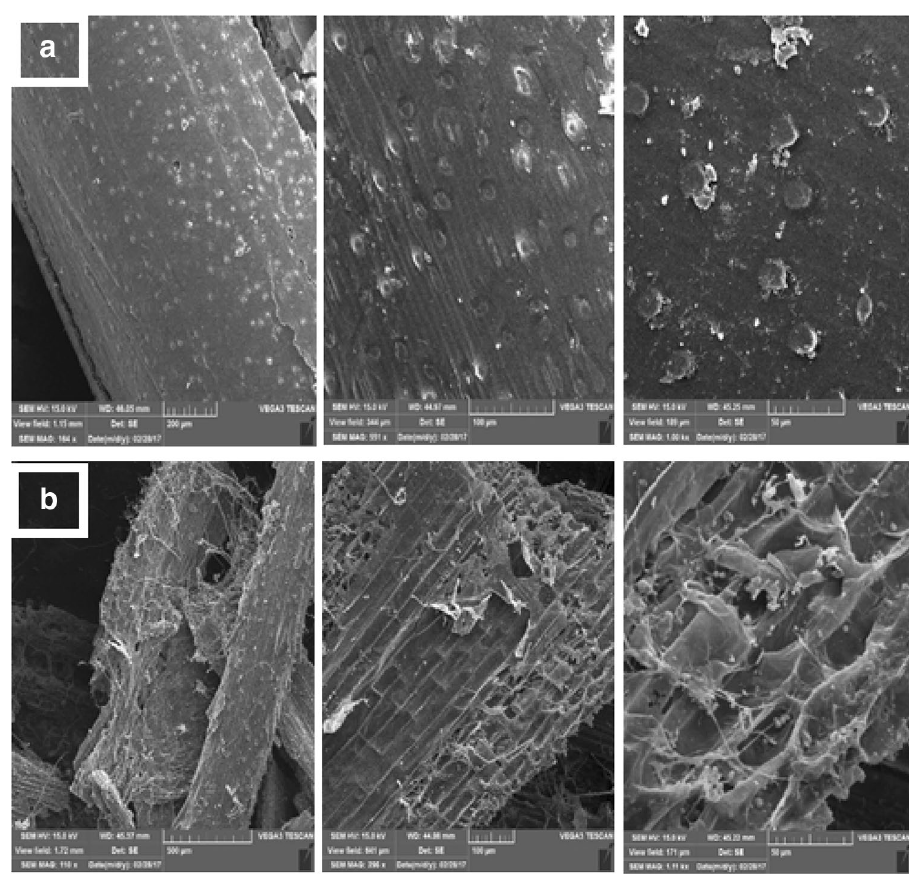
Fig. 3 Scanning electron microscopy (SEM) image indicating the inaccessible and packed structure of untreated wheat straw (top), and fungal hyphae penetration together with germinated spores in the channels and pores on fer- mented wheat straw